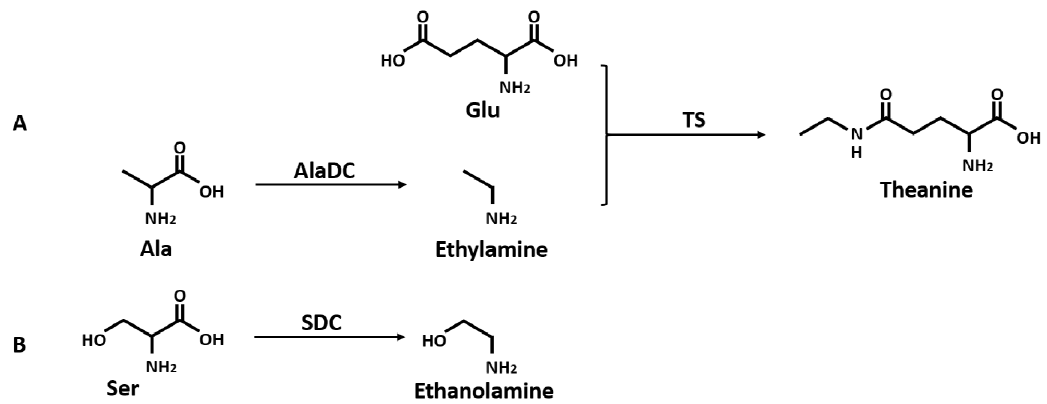
Figure 1. Biosynthetic pathway of theanine ( A ), and decarboxylation of Ser ( B ). AlaDC, alanine decarboxylase; TS, theanine synthetase; SDC, serine decarboxylase.